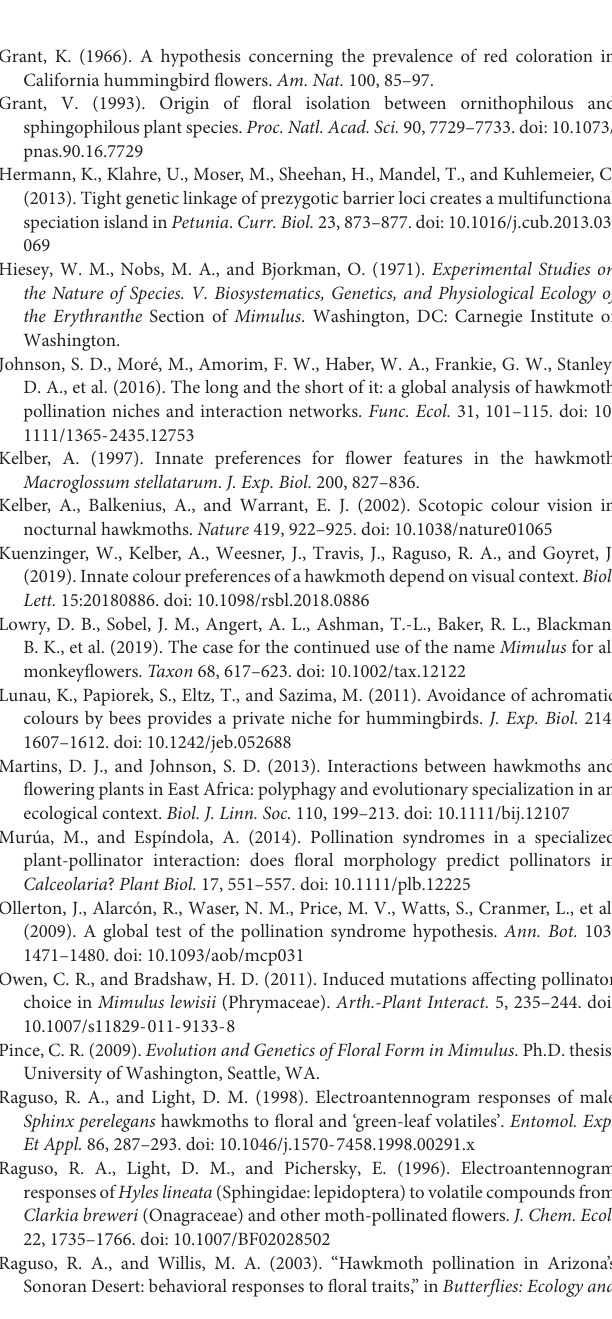
Supplementary Figure 1 | Carolina hawkmoth ( Manduca sexta ) feeding from white Mimulus mutant in flight chamber. Supplementary Figure 2 | Visit and visitation time data for individual moths. Individuals are presented in order of experiments, which were randomized, and the order is the same for parts (A,B) . (A) Total number of visits broken down by